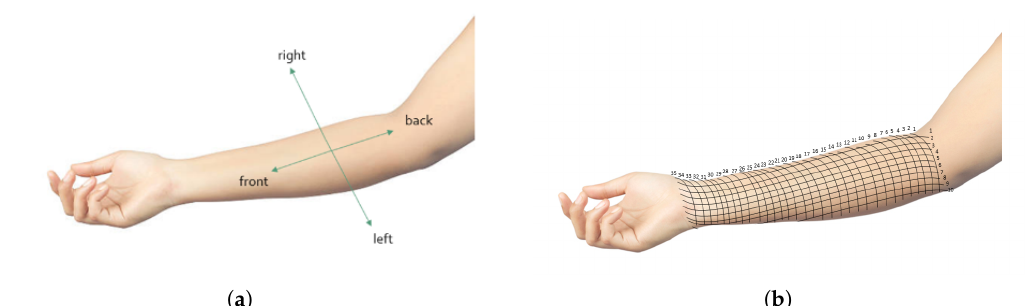
Figure 2. Direction of the angles in the image acquisition ( a ) and positions of acquisitions points during the image acquisition ( b